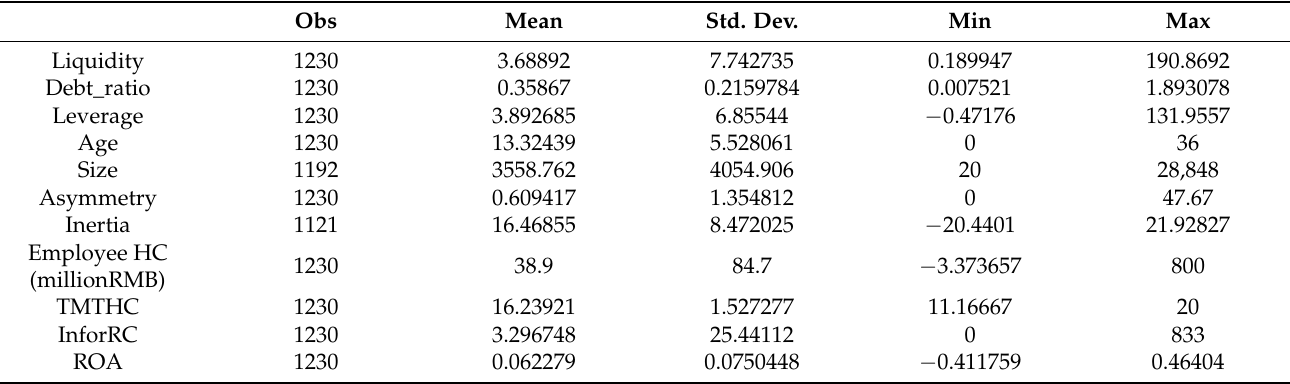
Table 2. Summary of variables.